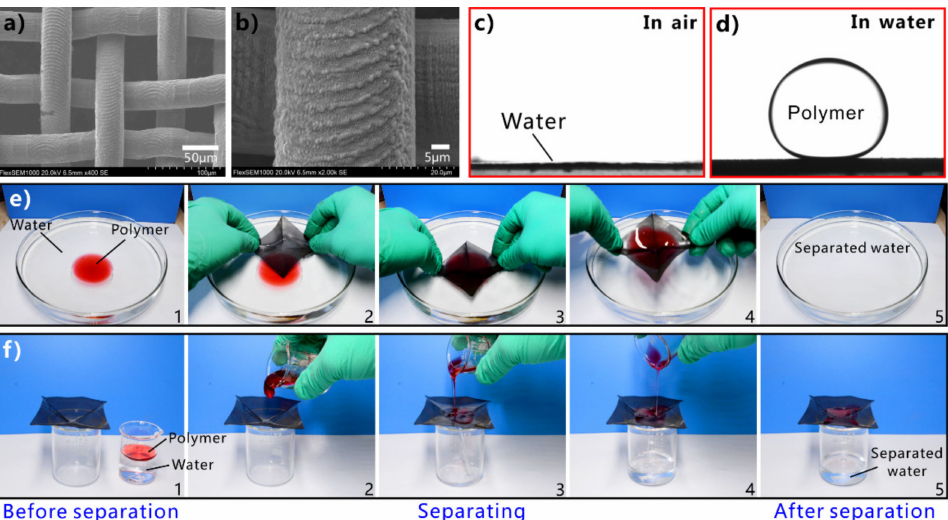
Figure 23. Separation of liquid polymer and water by using the underwater superpolymphobic mesh. ( a , b ) Surface microstructure of the laser-ablated stainless-steel mesh. ( c ) Water fully wetting the structured mesh. ( d ) A droplet of liquid polymer on the structured mesh in water. ( e ) Removing liquid polymer on the water through the collecting manner. ( f ) Separating the polymer/water mixture by the filtration manner. Reprinted with permission from ref. [302]. Copyright 2020,